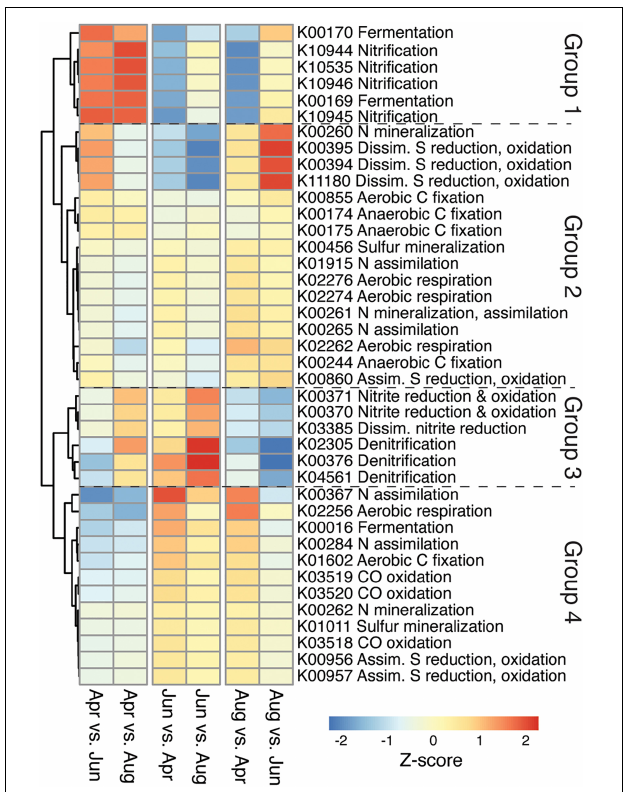
FIGURE 3 | Heatmap of z-scaled log2fold change determined by DeSeq2 of marker genes for ecological functions. Log2fold change determined as month to month comparisons, i.e., first column “Apr vs. Jun” is April gene abundance as compared to June gene abundances. Red indicates higher abundance and blue indicates lower